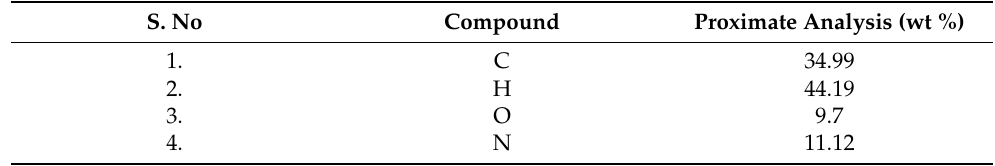
Table 3. Proximate analysis of coal used in